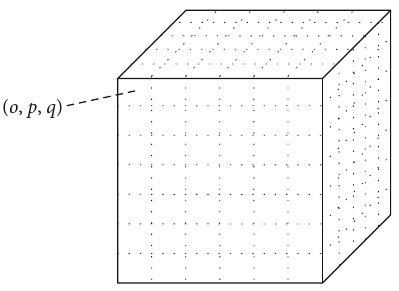
Figure 7: Sketch map of core